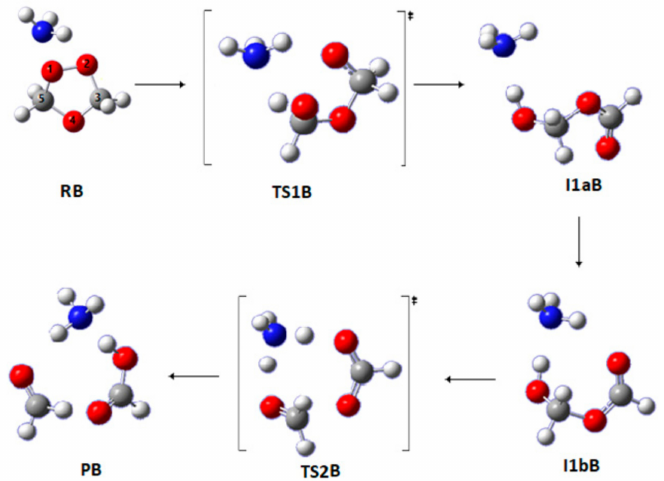
Figure 3. Optimized geometries for the stationary points in Pathway B of the reaction between SOZ and ammonia. Calculated at the APFD / 6-311 ++